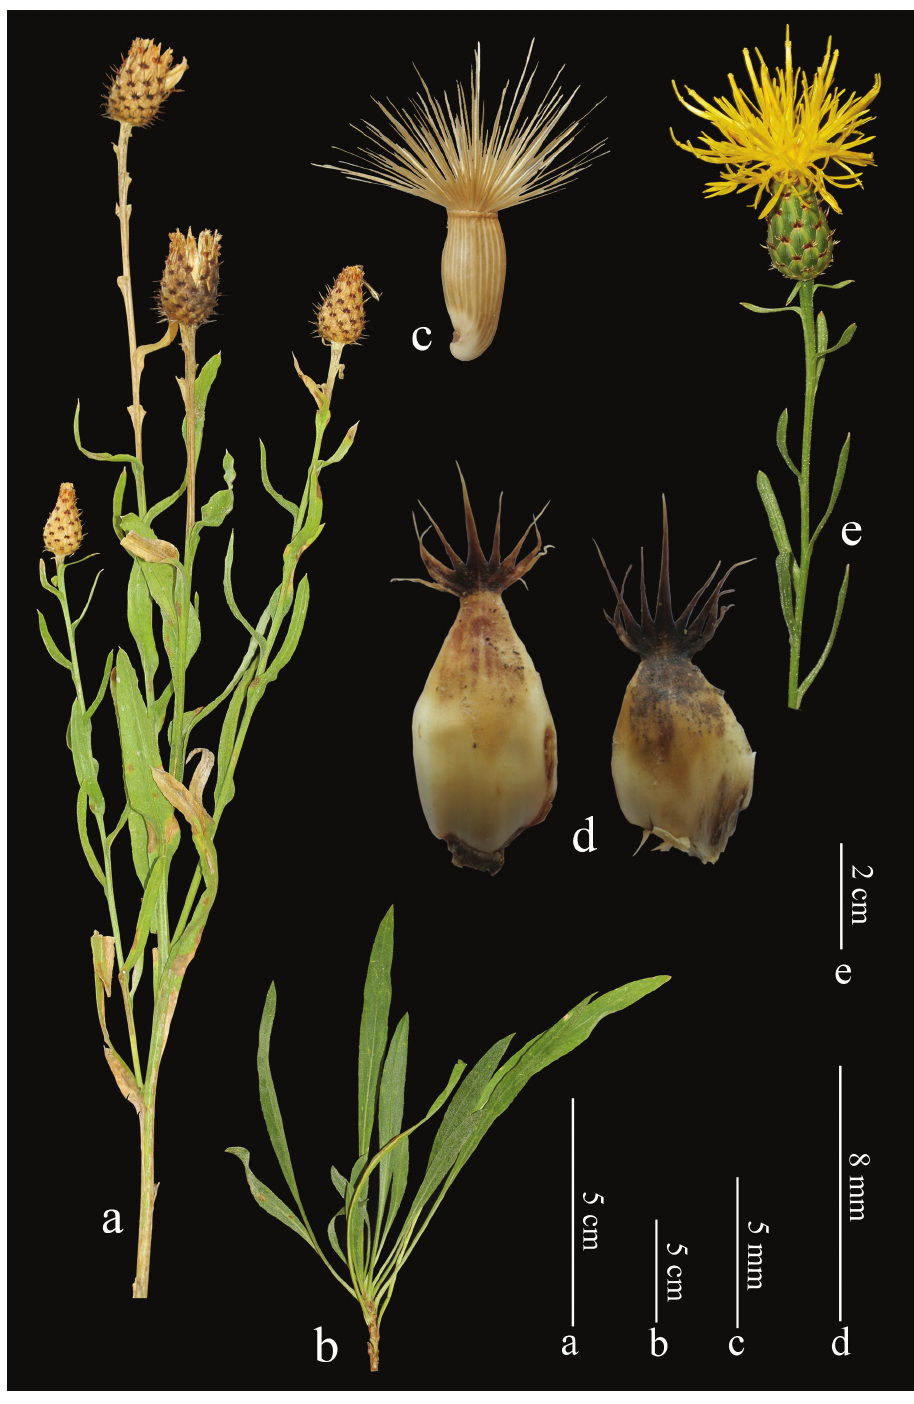
Figure 1. Centaurea ziganensis sp. nov. a habit b roset leaves c achene d median phyllaries e